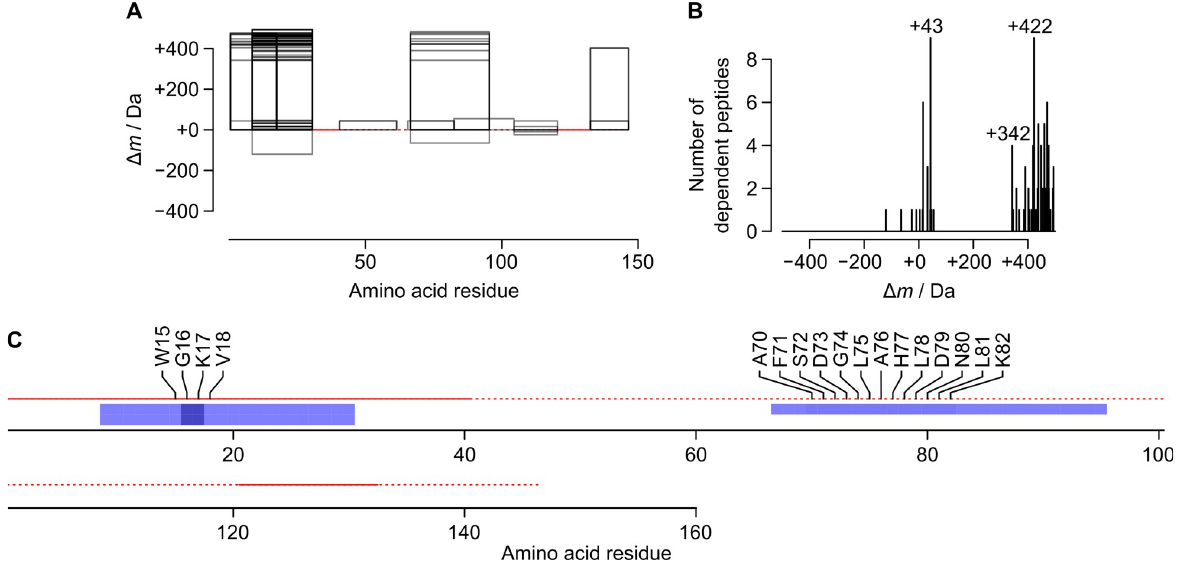
Fig 3. Visualisation of dependent peptides of human haemoglobin β -chain using public data from the study by Salomo´n et al. [28]. (A) Dependent peptide localisation plot. (B) Mass-shift ( Δ m ) frequency histogram. (C) Localisation plot for putative sulfonated ‘HDMP’-type modifications ( Δ m ± tolerance = +390.10 ± 0.01 Da) [28]. Six of 106 dependent peptides also mapped to the sequence of haemoglobin δ -chain (S11 Fig). Base peptide VLGAFSDGLAHLDNLKGTFATLSELHCDK went undetected in analyses of untreated proteins and therefore does not appear (see S1 Text of Table